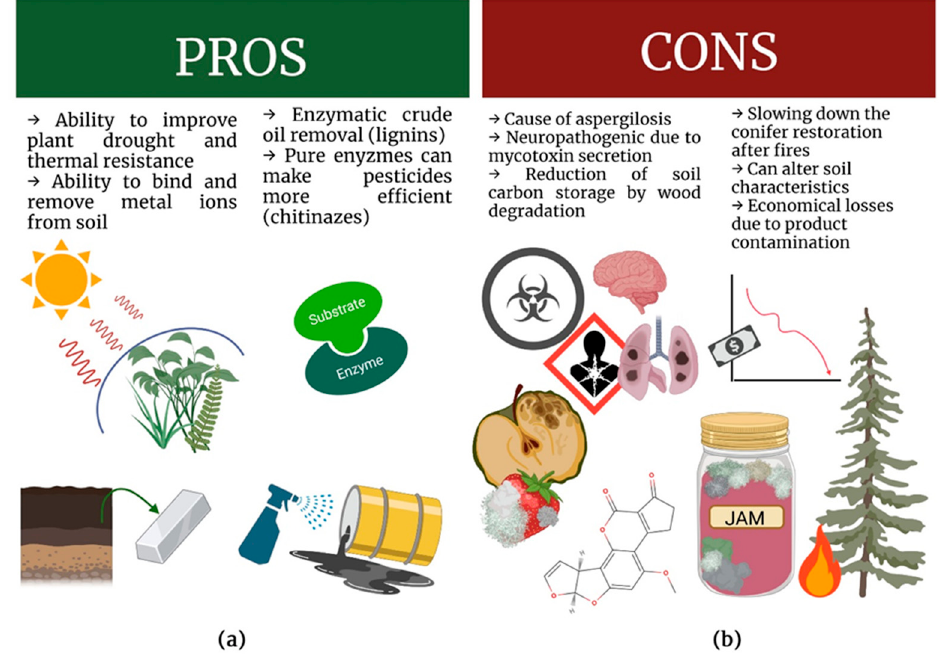
Figure 3. Positive and negative aspects of Neosartorya spp. ( a ) Positive aspects, ( b ) negative aspects; Own elaboration by W. Maj and M. Fr ą c using BioRender, Toronto, Canada. Aflatoxin B1 structure molview.org (accessed on 12 October 2022).